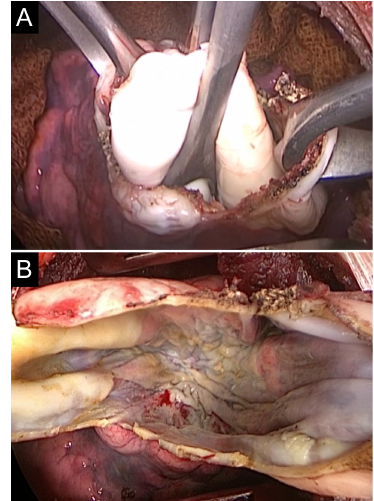
Figure 5. a,b. In a case of a giant hydatid cyst, intraoperative cyst membrane removal (a) and cyst cavity after membrane removal (b) are